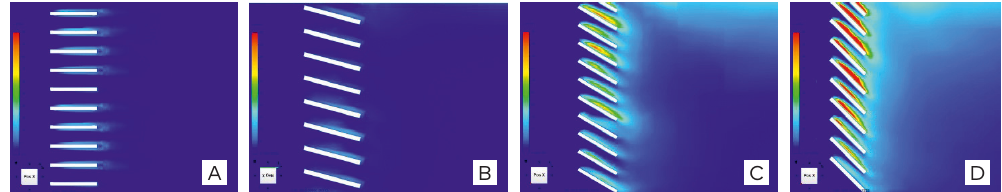
Figure 9. Energy growth per area of barrier with 10 mm thickness of mineral